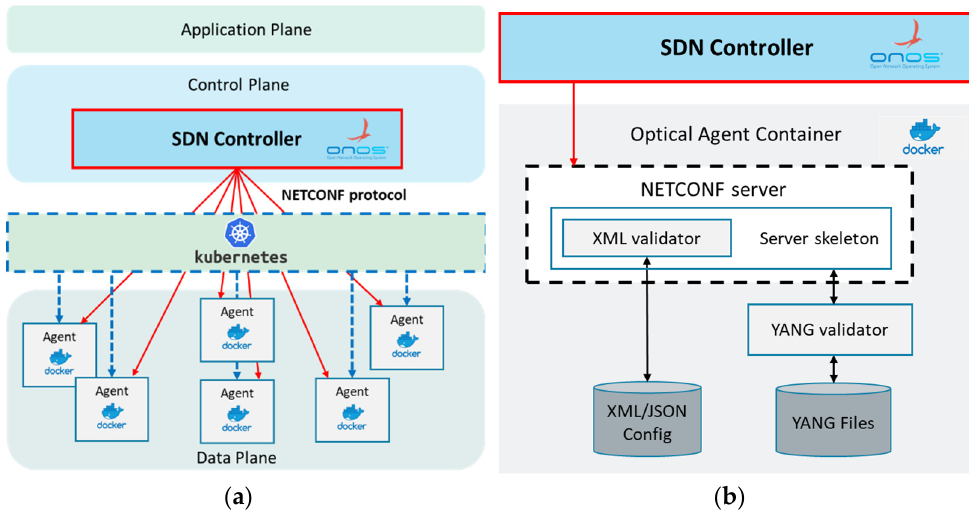
Figure 2. Architectural details of the proposal: ( a ) General overview of the architecture for the Advanced Automatic Deployment of an emulated software-defined networking (SDN) disaggregated optical network (DON) framework; ( b ) Schema of the elements in a generic optical network agent.